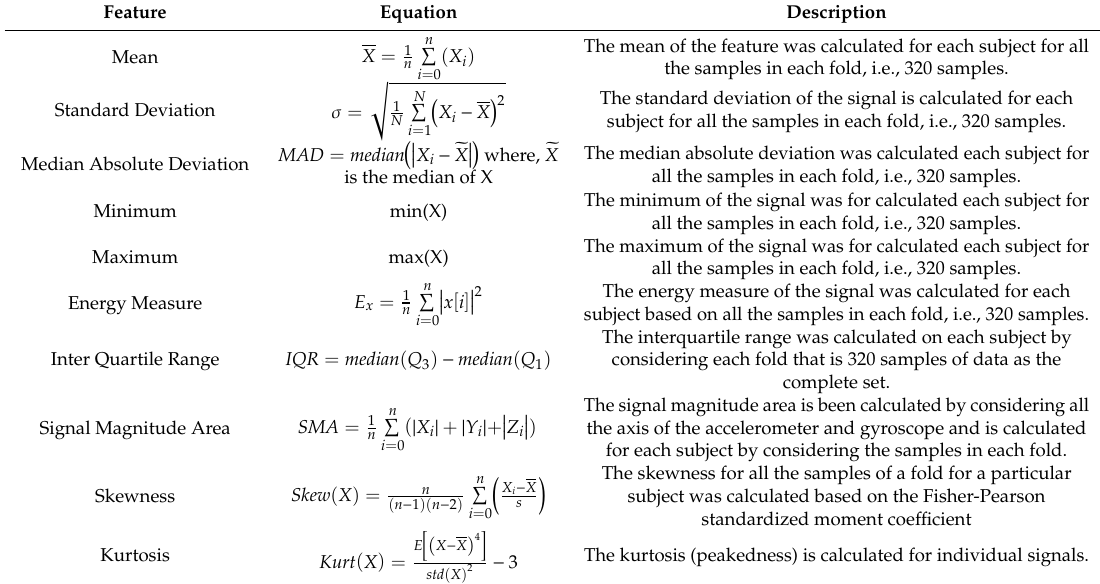
Table 3. Statistical